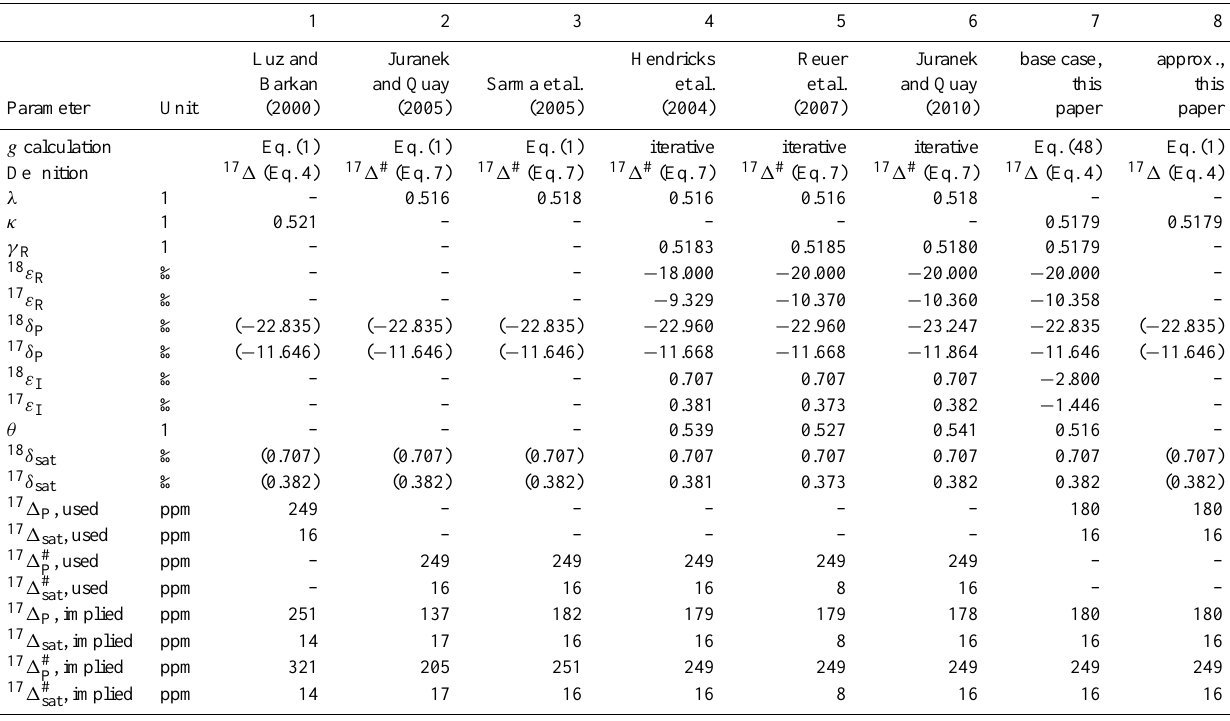
Table 3. Comparison between different calculation methods for g . A dash (–) or values in brackets mean that the corresponding parameters are not used in the calculation. The “used” 17 O excess values are used by the different calculation methods. The “implied” 17 O excess values are calculated using the definitions adopted by the different calculation methods, based on the listed 17 δ P , 18 δ P , 17 δ sat and 18 δ sat values. Where the calculation method does not require these δ values, the values for the “best case” in Table 2 have been used for the “implied” 17 O